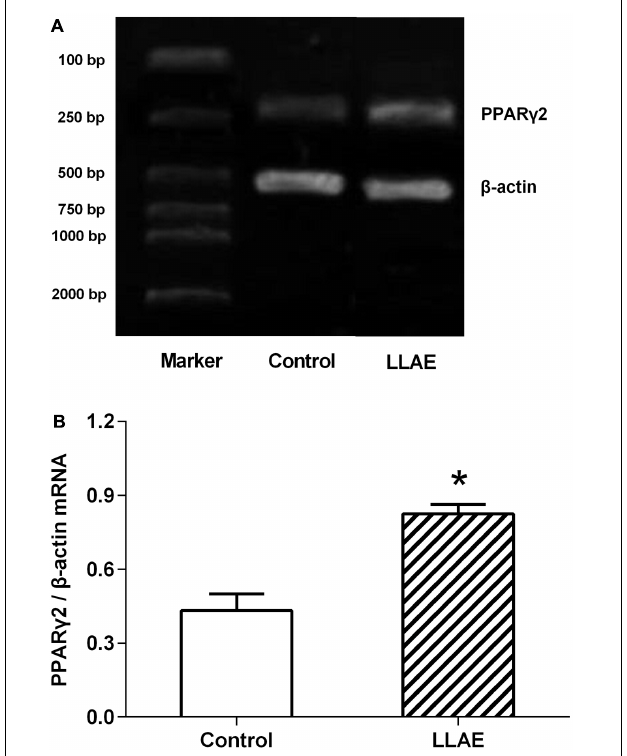
FIGURE 4 | Effects of LLAE on PPAR γ 2 expression in human adipocytes. Human primary preadipocytes were seeded in six-well plates at a density of 5 × 10 4 cells/well. The cells were then differentiated as described in Section “Materials and Methods.” On the sixth day of differentiation, the cells were treated with 100 µ g/ml LLAE for 36 h. The total RNA was extracted and RT-PCR was performed as described in Section “Materials and Methods.” (A) The RT-PCR products were electrophoresed in 2% agarose gel with ethidium bromide and photographed under ultraviolet light. (B) PPAR γ 2 expression in human adipocytes treated with LLAE was calculated by the density ratio of PPAR γ 2 to β -actin PCR products. The data represent the mean ± SD of three separate wells in three independent experiments. ∗ P < 0.01 vs. controls (without LLAE treatment).